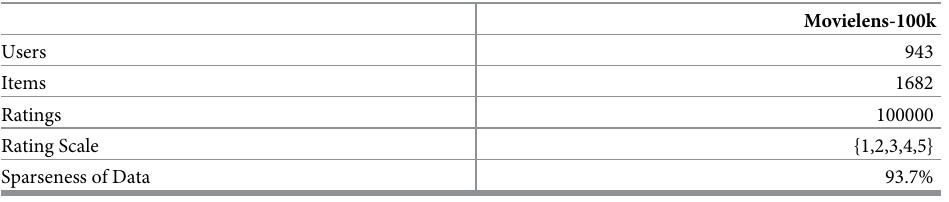
Table 3. User-item rating matrix.